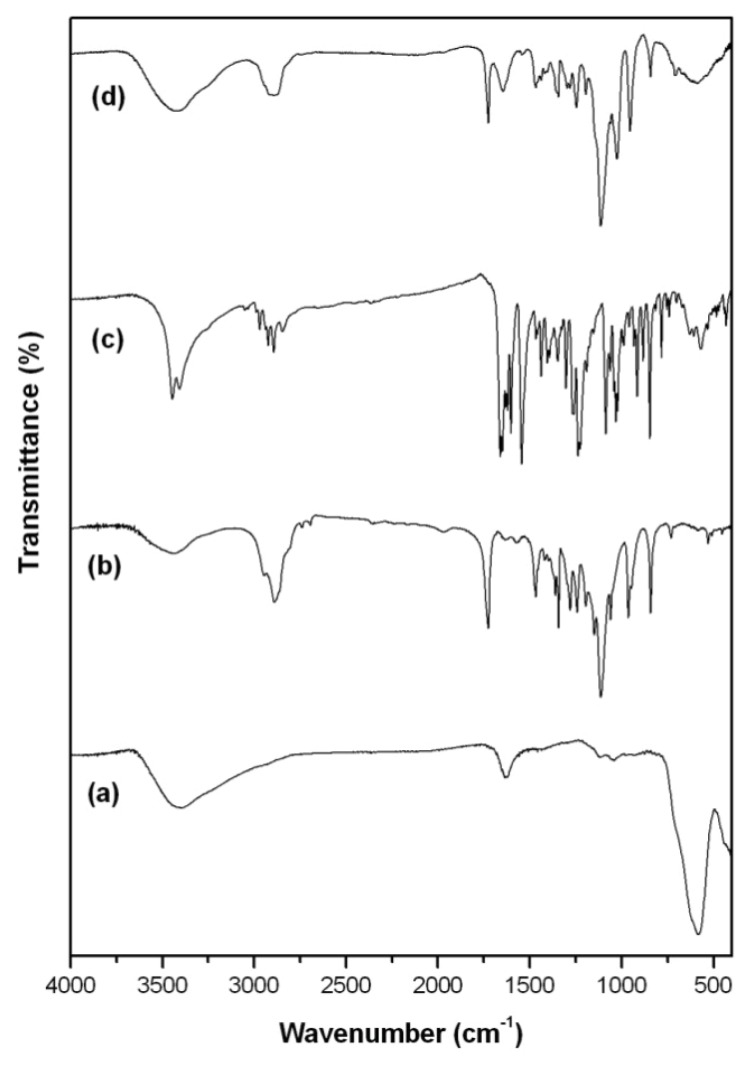
FTIR spectra: (a) Fe3O4; (b) Diblock copolymer E114Cl20; (c) Oncocalyxone-A and (d) MO-20.